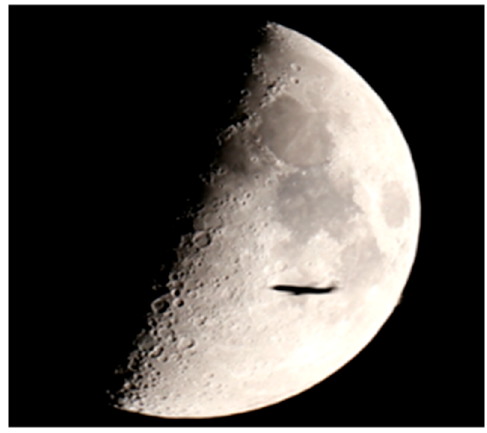
Figure 2. The airplane shadow against a lunar background.